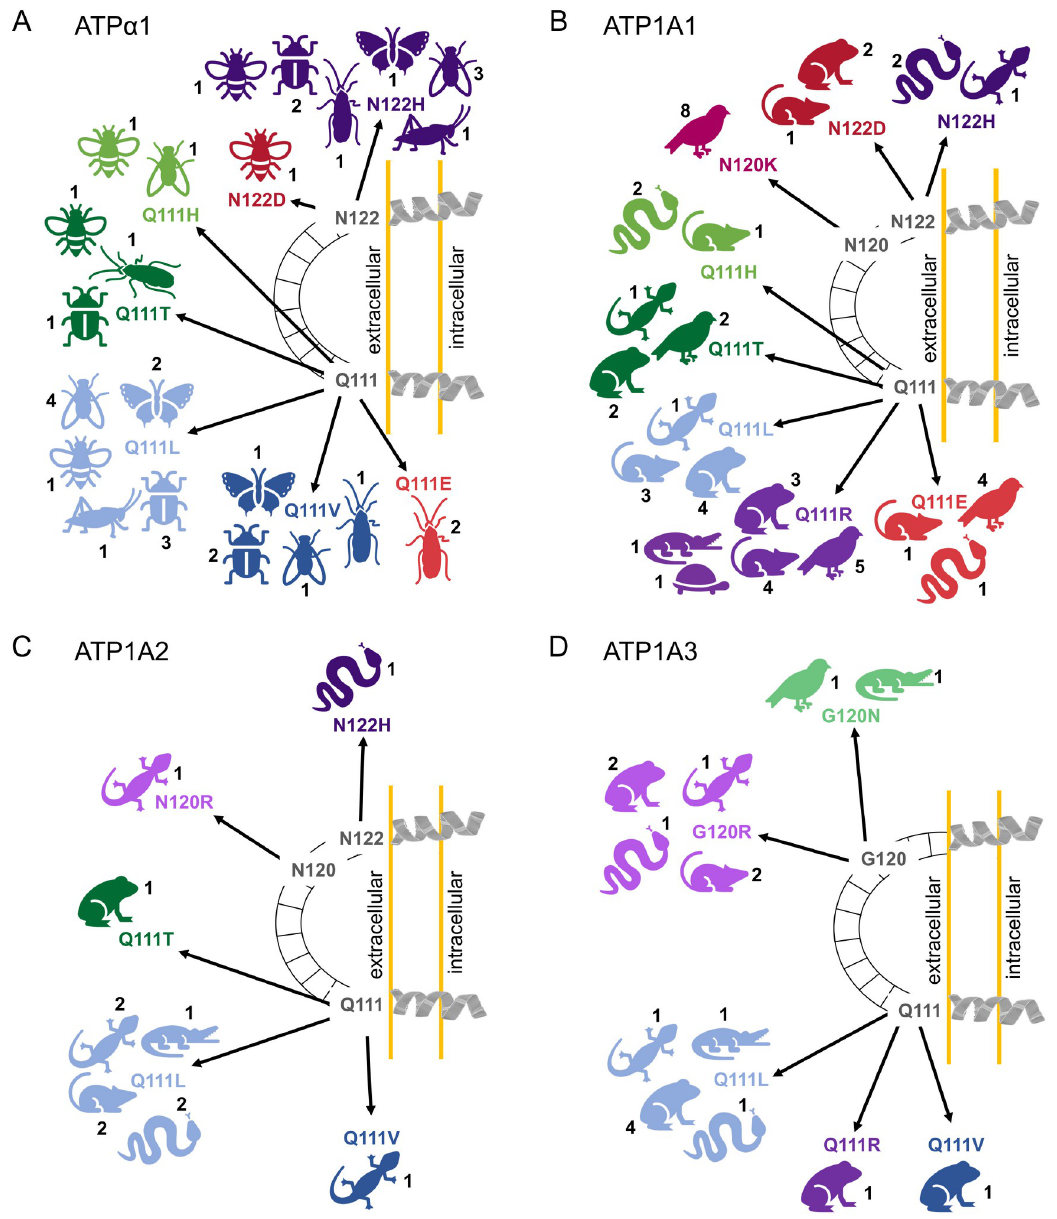
Fig 3. Parallel and divergent patterns of CTS-resistant substitutions across ATP α 1 of insects and the shared ATP1A paralogs of tetrapods. Examples of convergence in ATP α 1 across insects (A). Convergence in the (B) ATP1A1, (C) ATP1A2, and (D) ATP1A3 paralogs, respectively, across tetrapods. Numbers indicate the number of independent substitutions in each major clade depicted. For ATP1A3, resistance-conferring amino acid substitutions have been identified at site 120, and not 122. A full list of amino acid substitutions can be found in S2 Dataset for tetrapods, and Taverner et al. [24] for